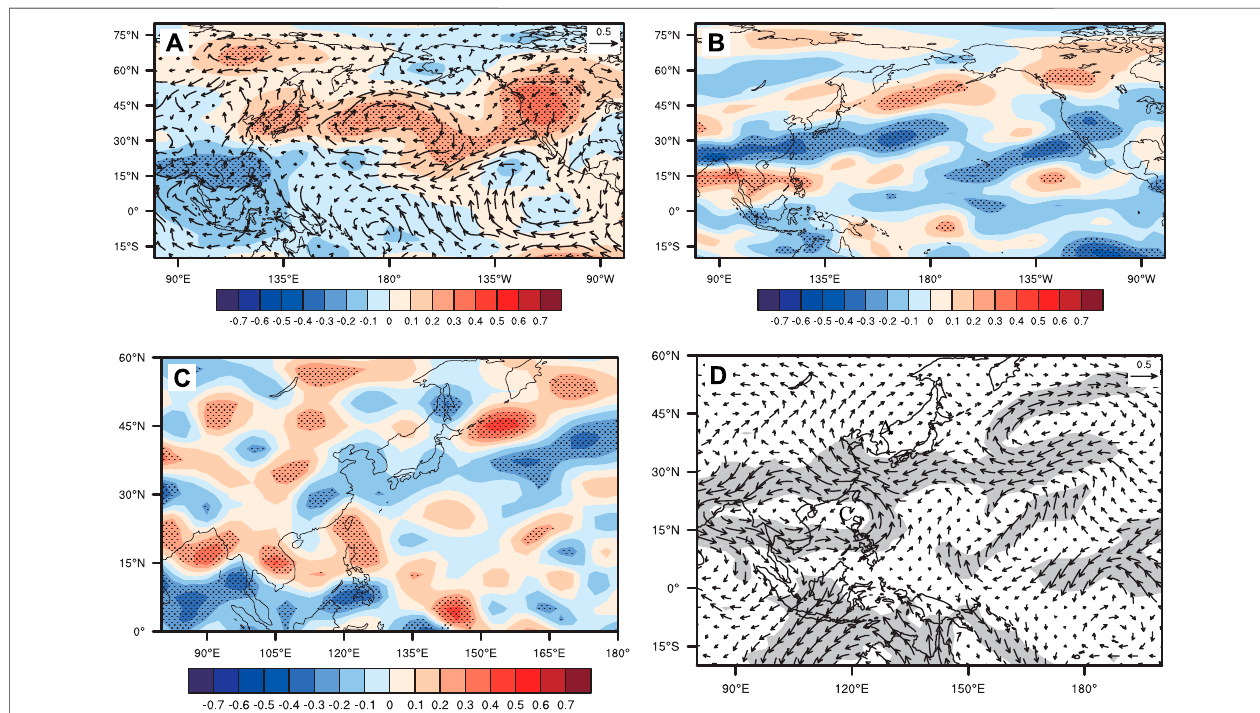
FIGURE 13 | The partial correlation coef fi cients between the West Wind Drift index in May – July and (A) 500 hPa geopotential height anomaly (shading) and 850 hPawind anomaly(vector), (B) 500 hPazonalwindanomaly, (C) 850 hPavorticityanomaly,and (D) steering fl owinJuly – September. Thedottedareasand shaded areas indicate the correlations that are signi fi cant at the 90% con fi dence level.